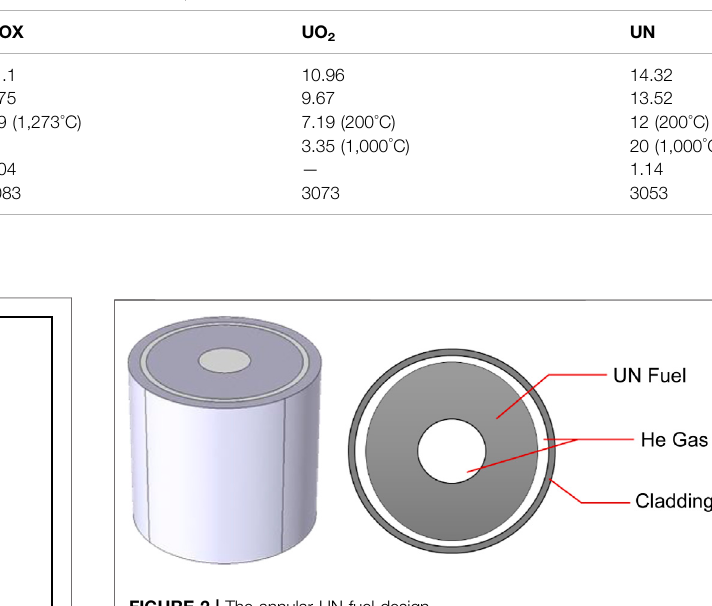
FIGURE 2 | The annular UN fuel